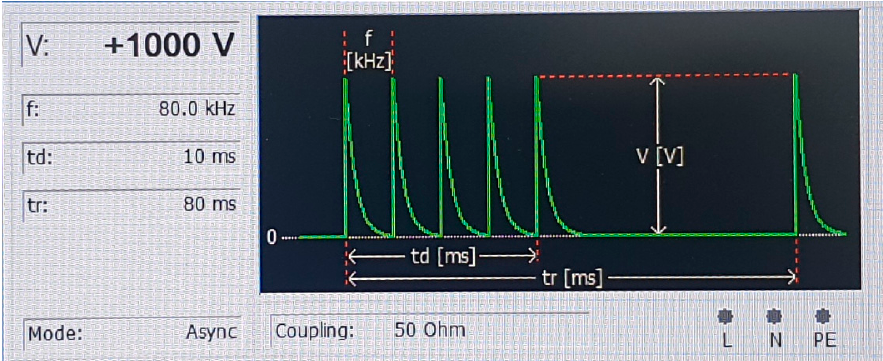
Figure 4. Representation of the incident periodic burst signal.